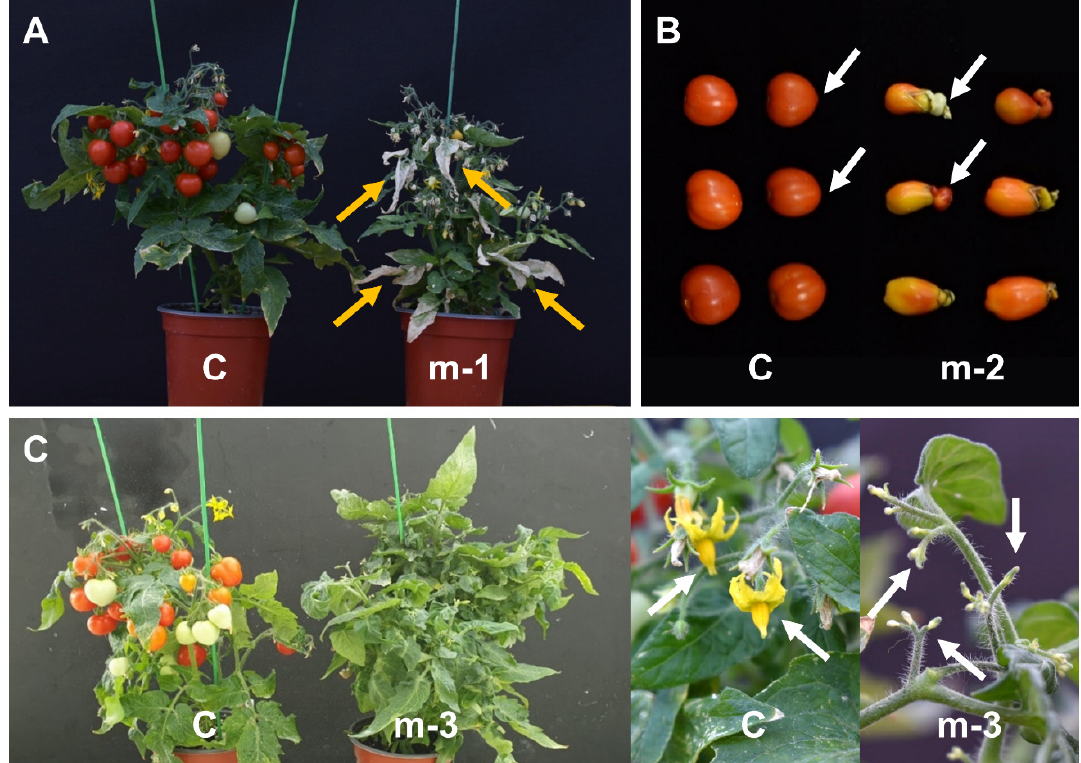
Figure 5. Various phenotypes of mutant M 2 plants. Mutants (m-1, m-2, and m-3) with different phenotypes compared with control (C) plants are shown. ( A ) An m-1 mutant with chlorotic leaves (indicated by arrows). ( B ) An m-2 mutant with abnormal fruit shape. Arrows indicate the tip regions developed from the stigma of the flowers. ( C ) m-3 mutant with bushy leaves and floral buds, which did not develop into flowers. Arrows indicate flowers and floral buds in WT and m-3 plants, respectively.